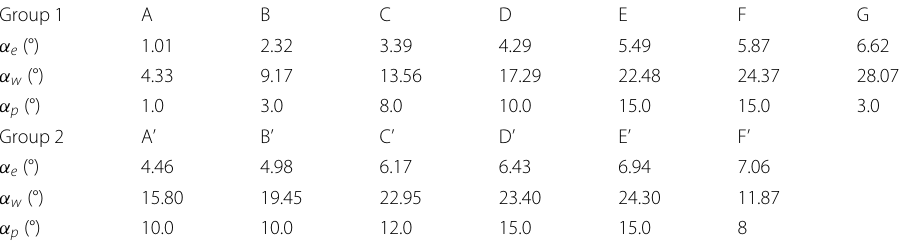
Table 3 The inclination angles of the high-frequency p w ( α p ) and those of the wall parallel velocity components at the edge of the boundary layer ( α e ) and the first layer of grid ( α w ) Group 1 A B C D E F G α e (°)